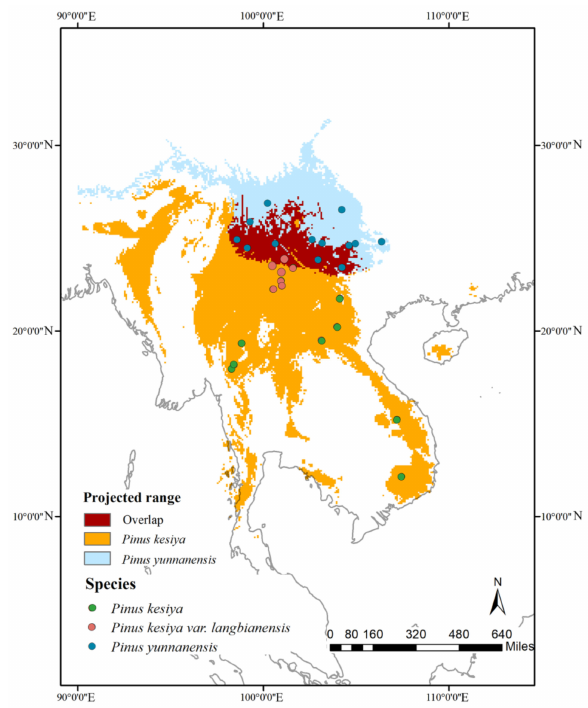
Figure 1. Sample locations of the three pine